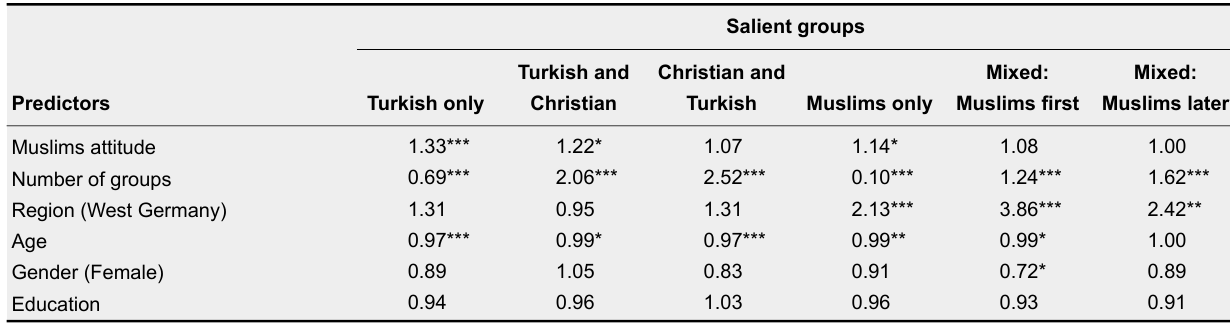
Association Between Attitudes Towards Muslims, Demographic Variables and Salience of Muslim Groups (Odds Ratios Versus Mentioning Only Non-Muslim Groups)